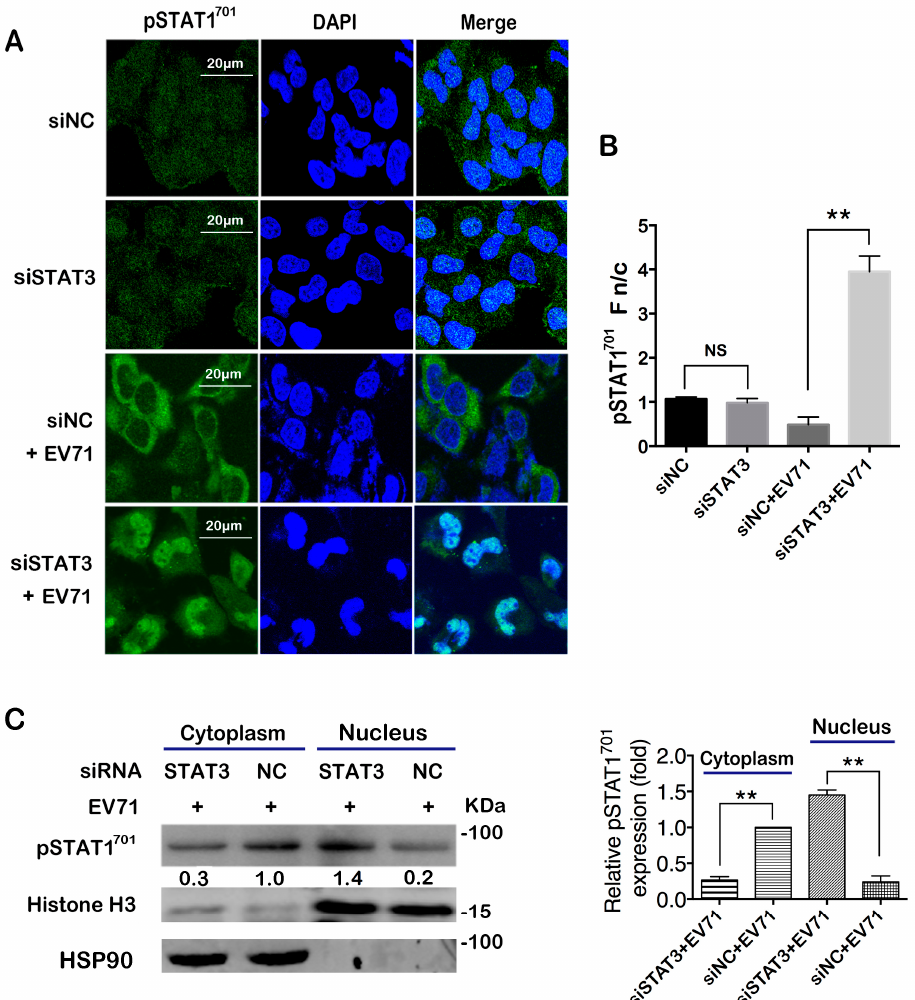
Figure 5. EV71-induced nuclear translocation of STAT1 was reduced in STAT3 knockdown cells. After STAT3 siRNA transfection and EV71 infection, ( A ) immunofluorescence (IF) assay was performed to